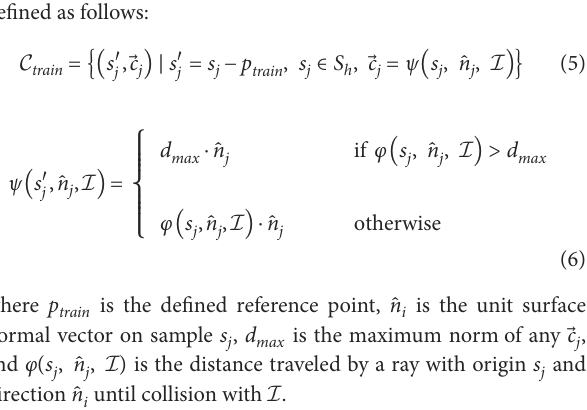
(Ruiz and Mayol-Cuevas, 2020). The provenance vectors of an interaction start from any point on I and finish on M